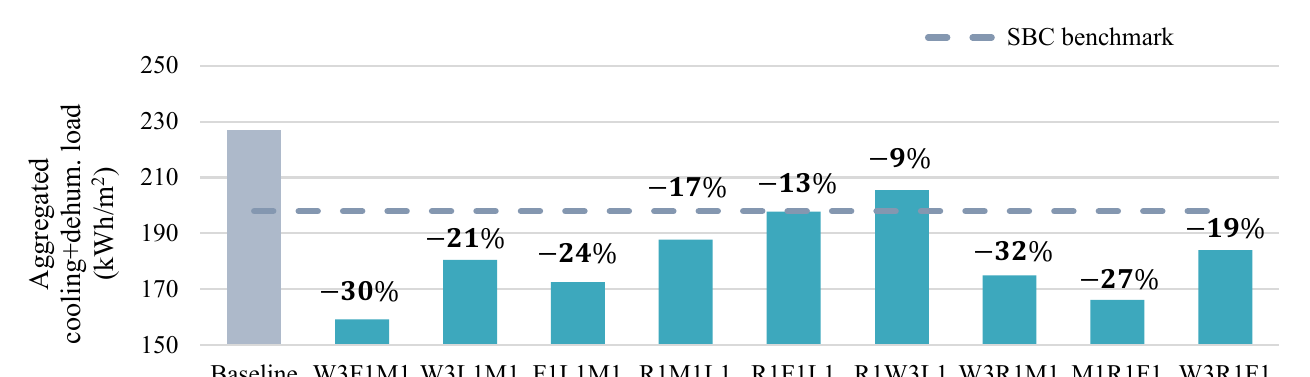
Figure 17. Comparative analysis of the energy performance of the retrofitting packages. On a final note, Figure 18 verifies the strong correlation between reducing solar gains and meeting the SBC benchmark, where the best performing from a cooling load reduction perspective were the combinations that managed to slash the solar gains significantly.